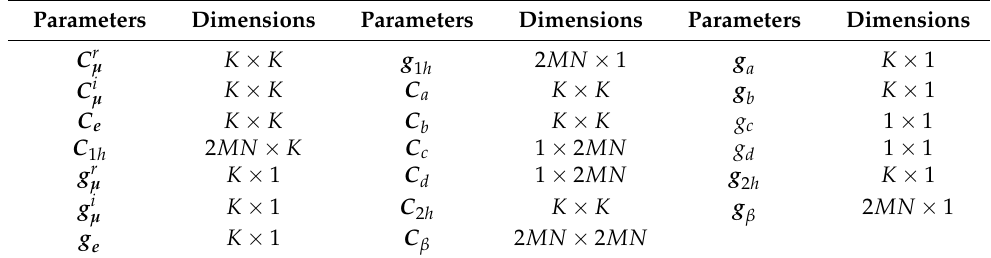
Table 1. Parameters in the inference network.